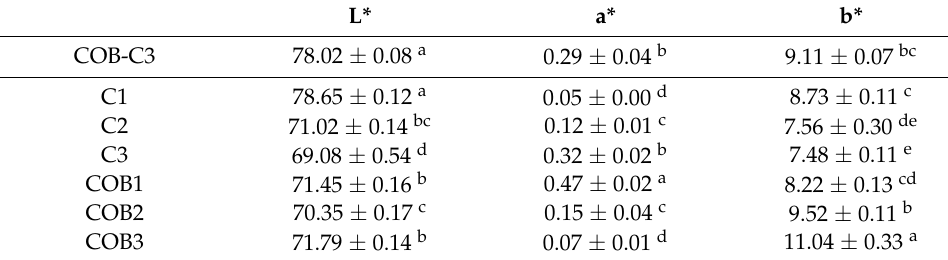
Table 5. Color values and sensory analysis of vegan ice cream mixes.